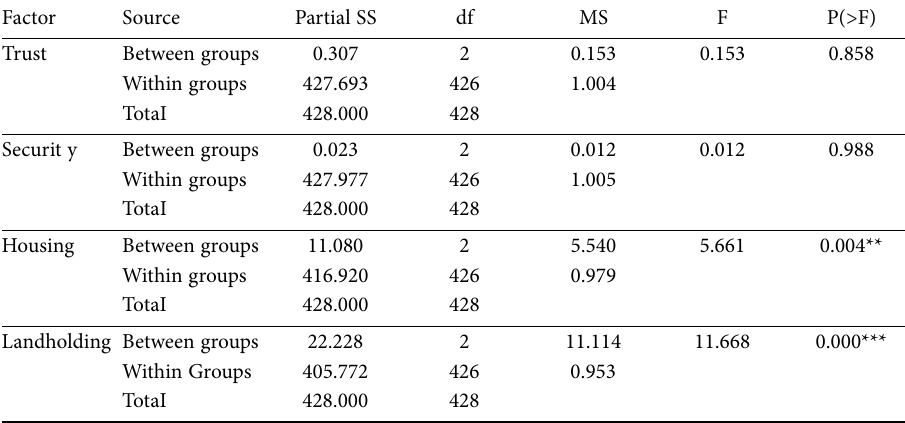
Table 8. One-factor ANOVA for the influence of sub-county on the factors trust, security, housing, and landholding.